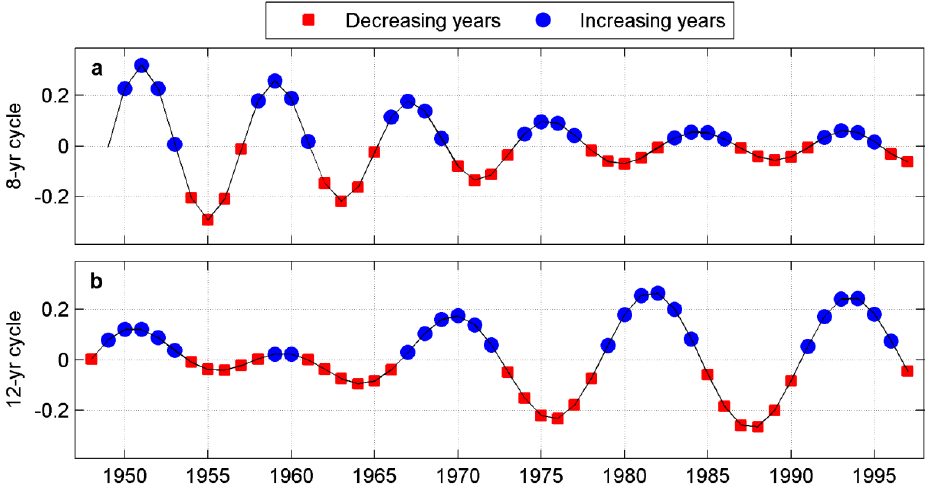
Figure 8. ( a ) Derivatives of 8-y lake-level reconstruction (cid:1856)(cid:1838) (cid:3052)(cid:3045)(cid:3030)(cid:2876) and ( b ) the 12-y reconstruction (cid:1856)(cid:1838) (cid:3052)(cid:3045)(cid:3030)(cid:2869)(cid:2870) (black lines), and categorization of phases: increasing lake-level years (blue circles) and decreasing lake-level years (red